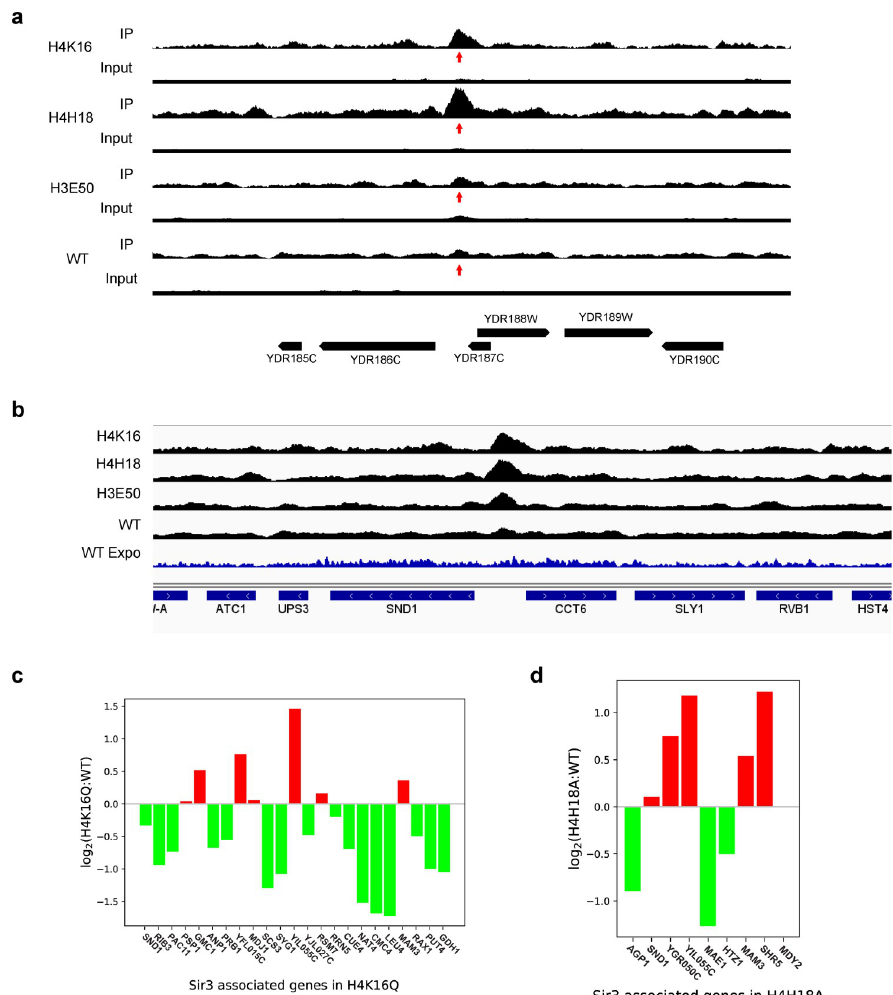
Fig 6. Binding of Sir3 to secondary loci in the genome. ( a ) The normalised level of bound Sir3 in a region of the right arm of chromosome IV is shown for the H4K16Q, H4H18A, H3E50A and WT strains. The arrow identifies a Sir3 peak present upstream of the YDR186C (SND1) gene in the H4K16Q and H4H18A strains, but not in the H3E50A or WT strains. ( b ) IGV Sir3 ChIP-seq tracks for the H4K16Q, H4H18A, H3E50A and WT strains at day 6, and the blue track of WT Sir3 ChIP-seq at exponential phase (Expo) from [36]. Bar graphs showing average log2 fold change for the genes associated with secondary Sir3 peaks in H4K16Q ( c ) and H4H18A strains ( d ). Wald test estimated the standard error of log2 fold change using two biological